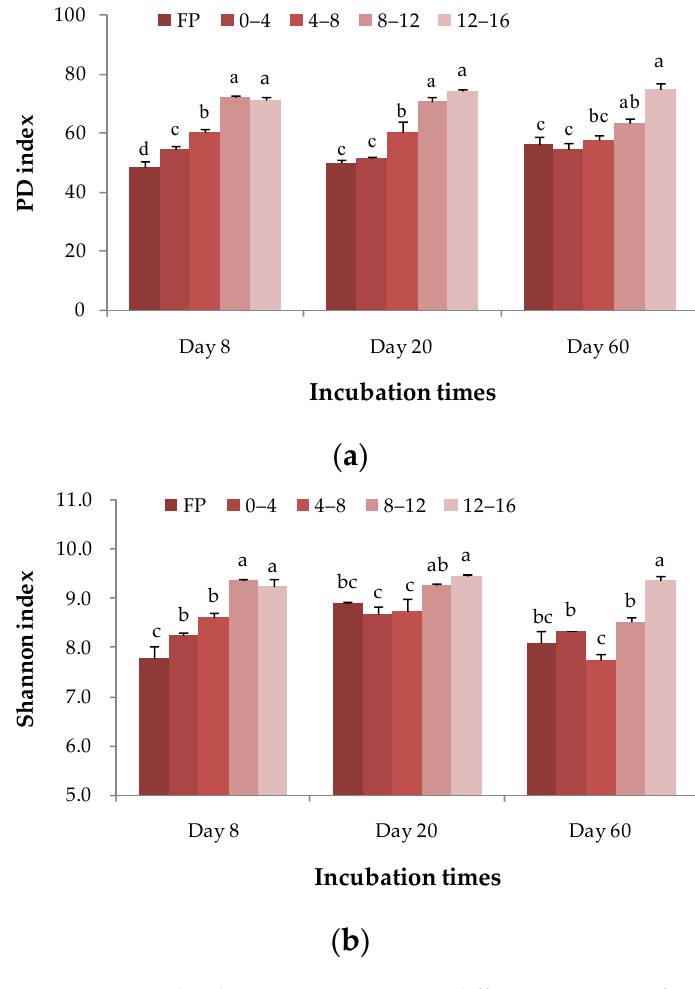
Figure 4. Bacterial α‐ diversity in response to different treatments for Qidong (QD) soil. ( a ) Faith’s phylogenetic diversity index (PD) index. ( b ) Shannon index. Vertical bars are standard error ( n = 3). Different lowercase letters above the bars indicate significant differences among treatments (LSD, p < 0.05) under the same incubation time.